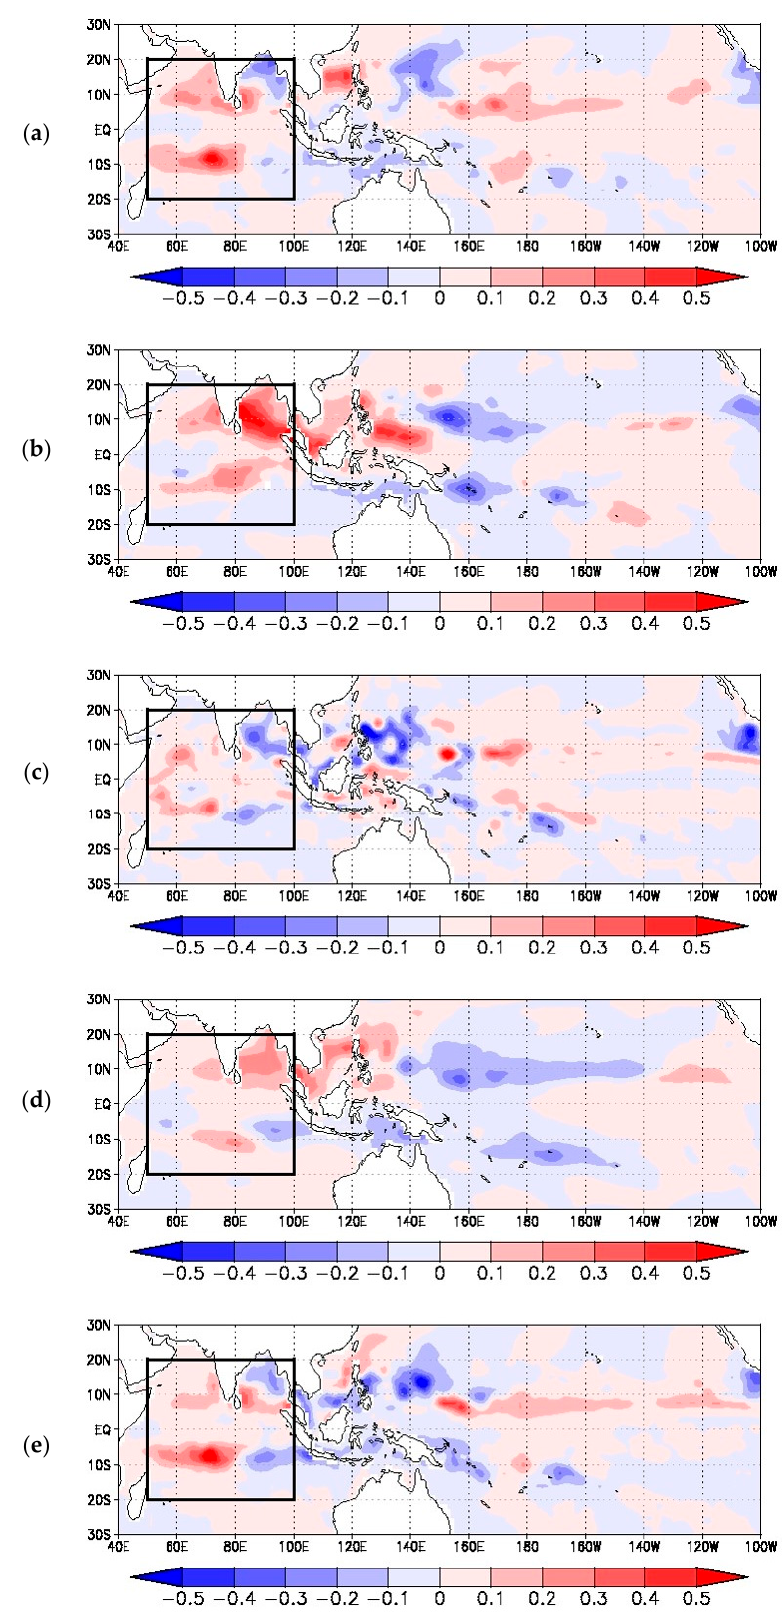
Figure 5. The same as Figure 3, except for the GPI anomalies in the MJO active years from ( a ) relative humidity; ( b ) vertical shear; ( c ) vorticity; ( d ) MPI; and ( e ) vertical velocity.